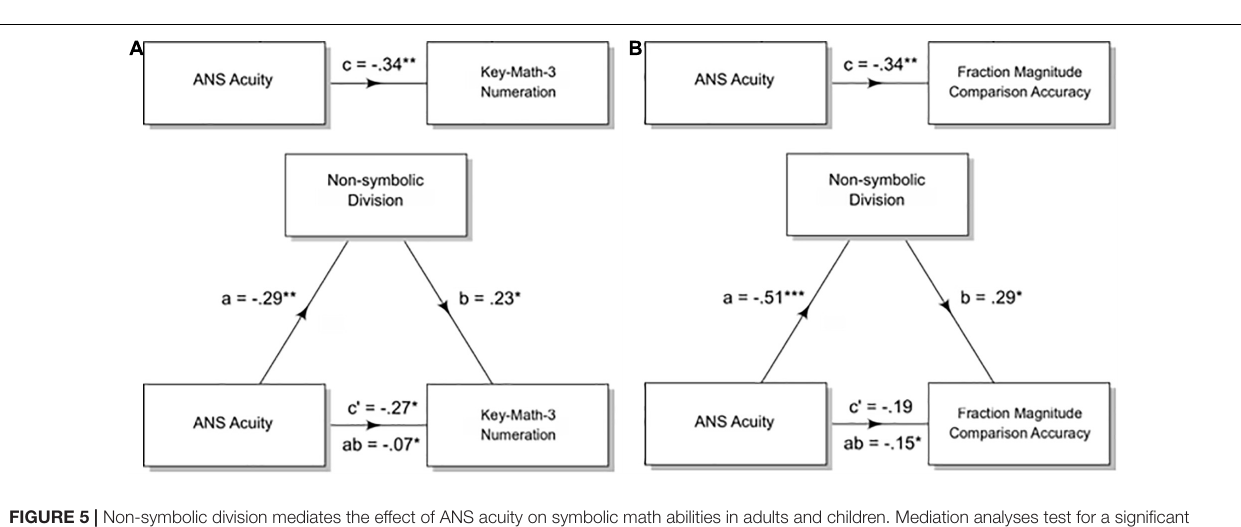
FIGURE 5 | Non-symbolic division mediates the effect of ANS acuity on symbolic math abilities in adults and children. Mediation analyses test for a significant indirect effect (the product of the standardized coefficients a and b) that accounts for some portion of the original direct effect (c). The remaining direct effect is represented as c’. The models in this figure test whether non-symbolic division performance mediates the relation between ANS acuity and a measure of formal math skills in children (Key-Math-3 Numeration) and adults (Fraction Magnitude Comparison). (A) Non-symbolic division accuracy partially mediates the relation between ANS acuity and a child’s score on the Key-Math-3 Numeration section. Both the indirect (ab) and the direct path c’ are significant. (B) Non-symbolic division accuracy fully mediates the relation between ANS acuity and accuracy on the fraction magnitude comparison test. The remaining direct effect (c’) is no longer significant, while the indirect effect (ab) is significant as tested with a bootstrap estimate approach. * < 0.05, ** < 0.01, *** <